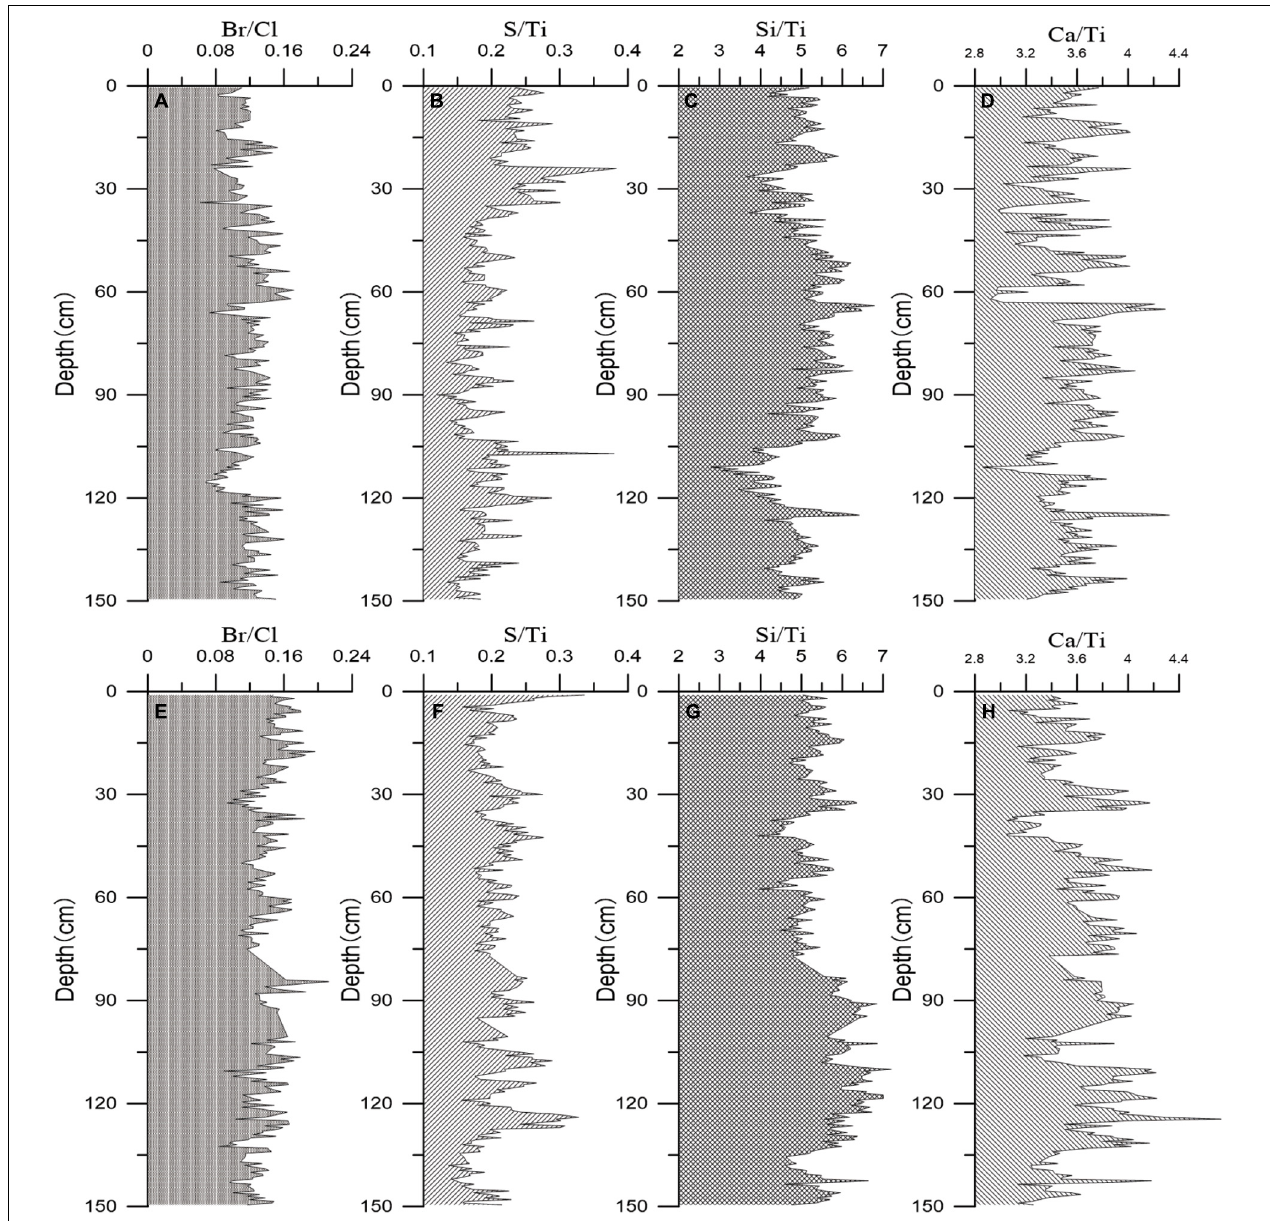
FIGURE 8 | Variation of the element ratios over time in core Z7 (A–D) and Z8 (E–H) . Element ratios of Z7 shifted significantly after 1999 (the depth of 40 cm), and element ratios of Z8 did not show a clear